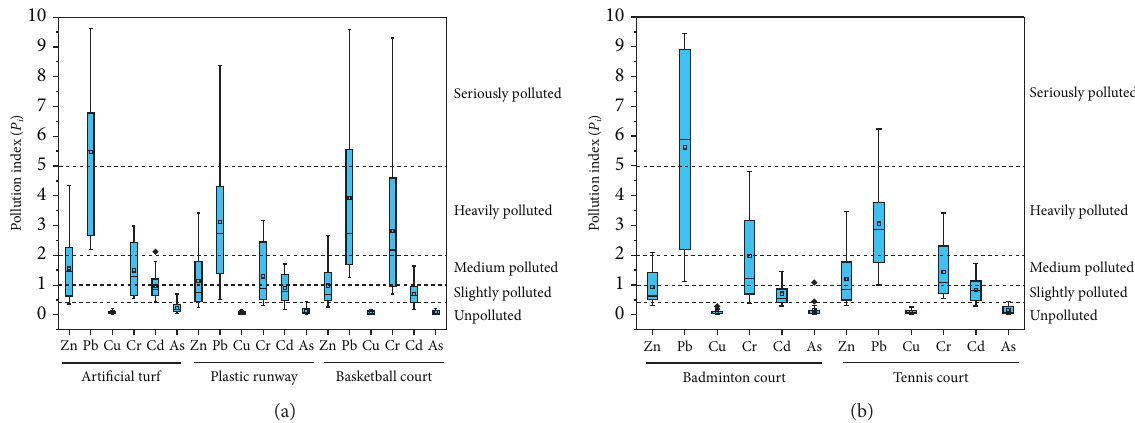
Figure 5: Box-plot of the single factor pollution index ( P dashed lines indicate the different pollution class by Yan et al. (2015) [13].